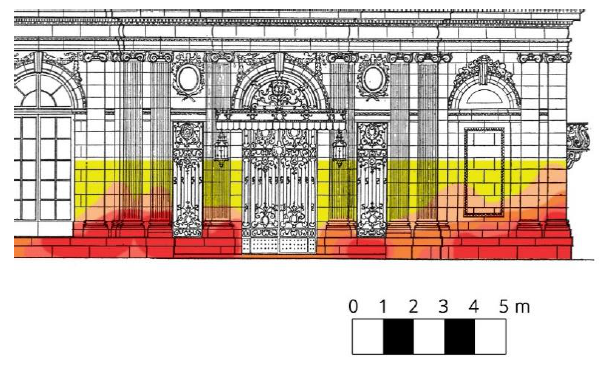
Figure 3. An image of building walls’ dampness developed on the basis of the results of an electrical test. Higher moisture concentrations are depicted by a color of higher intensity [17].